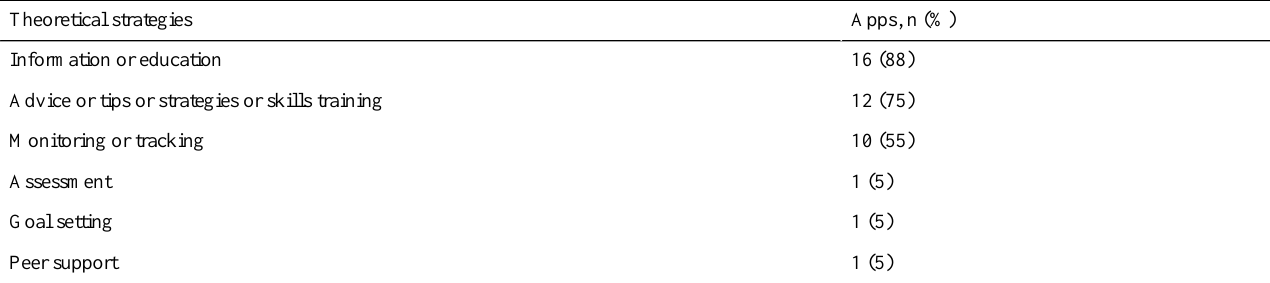
Table 2. Theoretical strategies classified by the Mobile Application Rating Scale